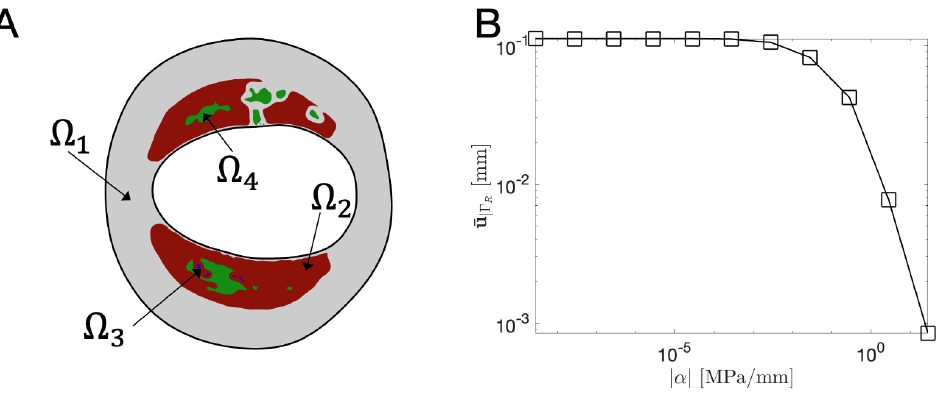
Ω k . ( B ) Elastic bed coef- k = 1